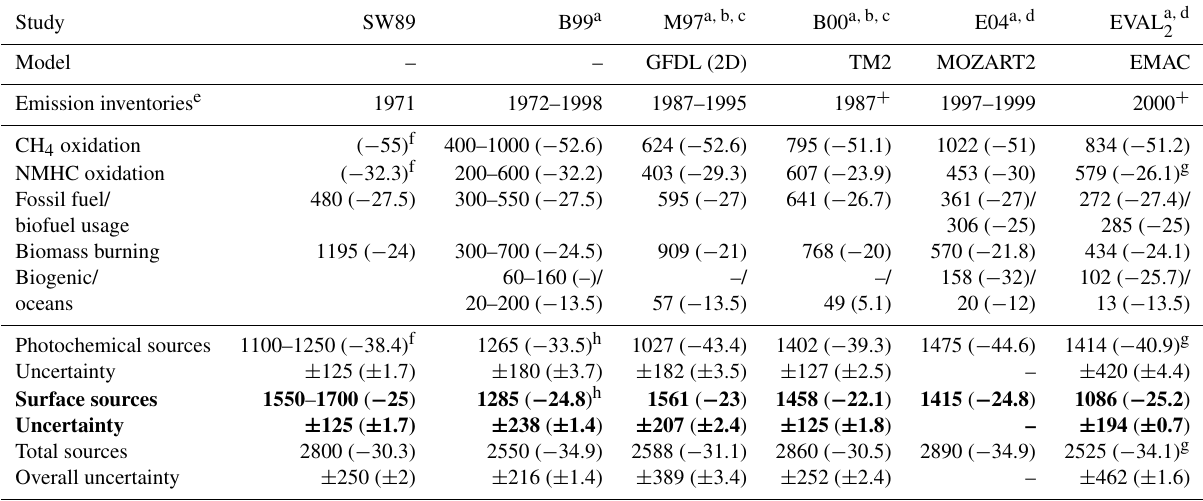
Table 7. Tropospheric CO sources and their isotopic composition from the present and previous studies.